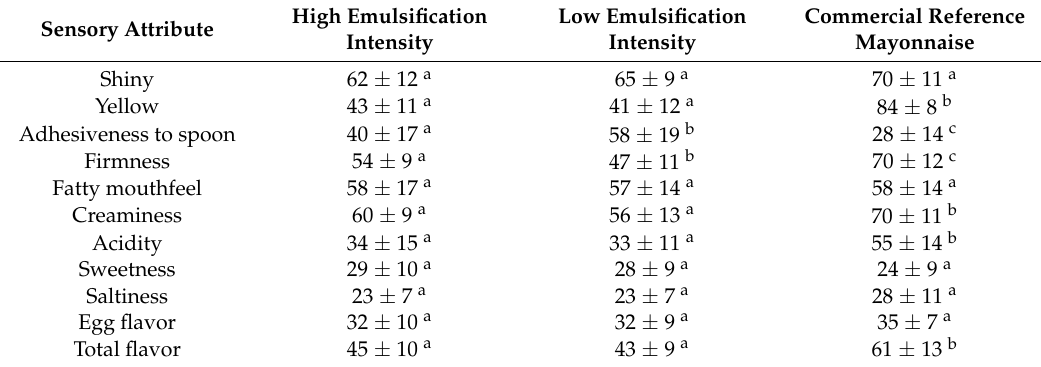
Table 5. Sensory evaluation of the intensity of selected attributes, comparing the experimental mayonnaises and the commercial reference. Different letters in the same row indicate significant differences at p ≤ 0.05.